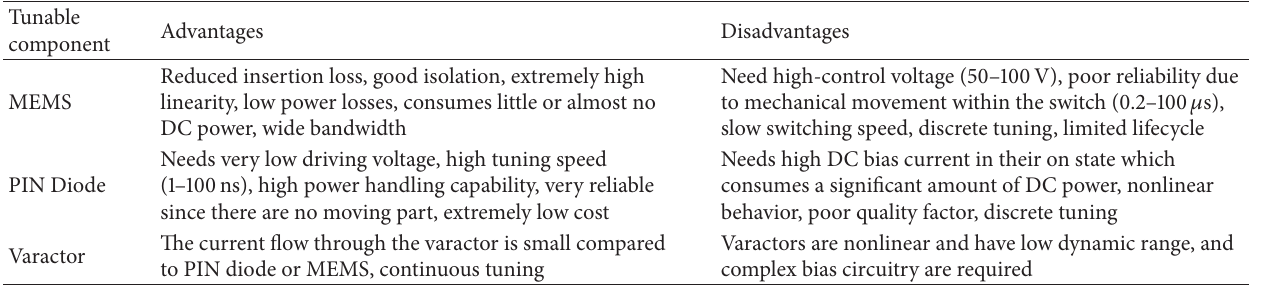
Table 1: Comparison of tunable components.